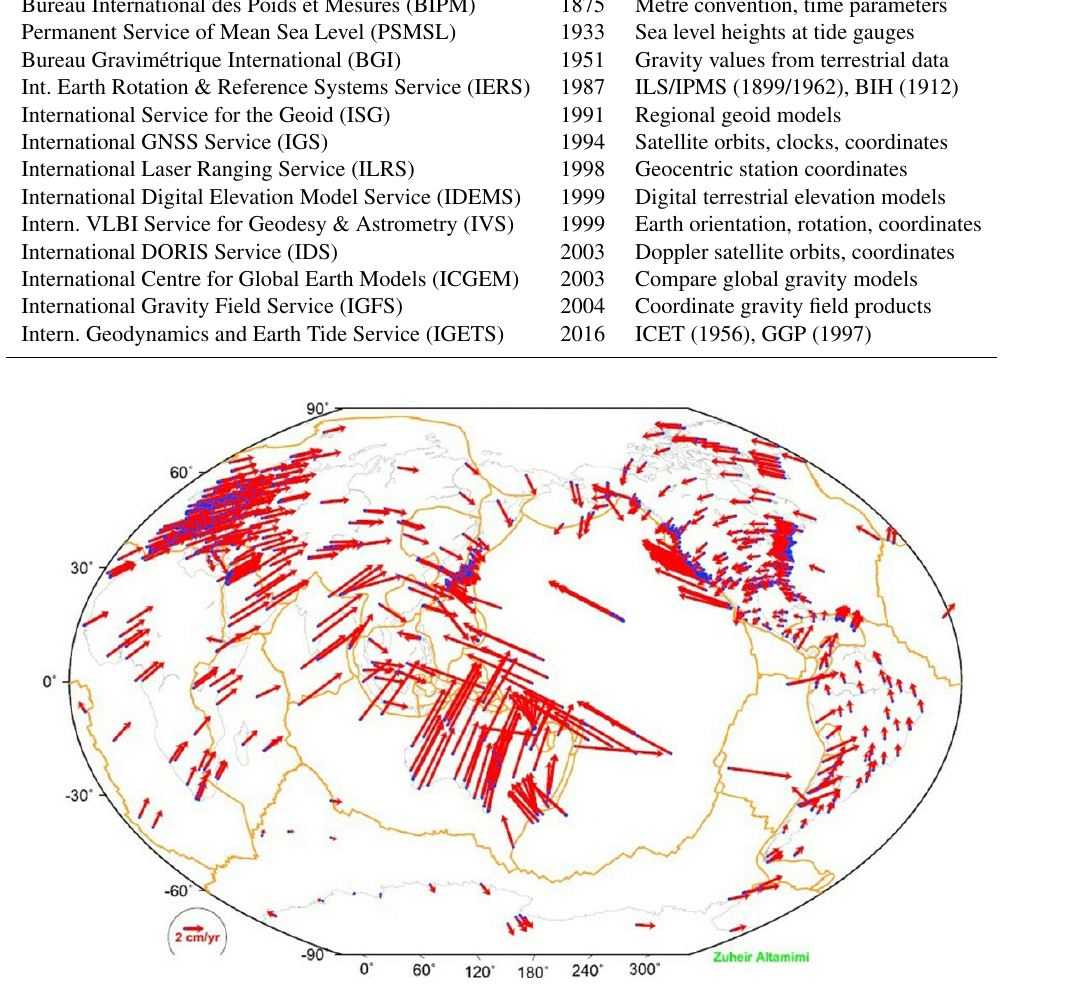
Figure 7. Station velocities of ITRF2014 (Altamimi et al., 2016).